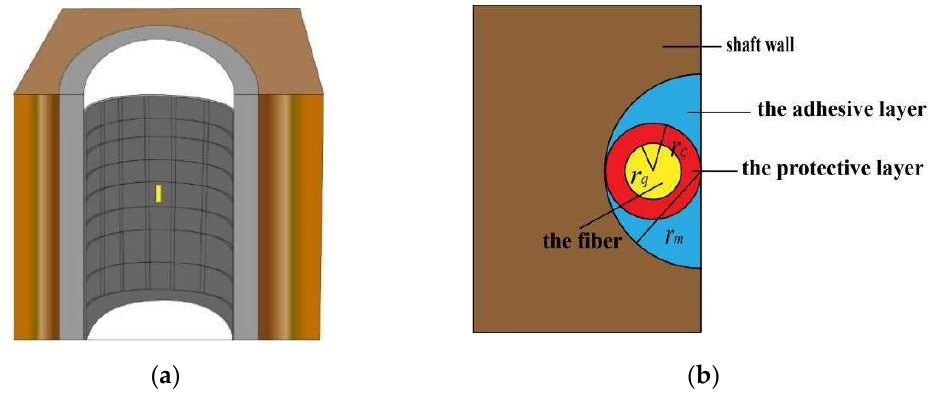
Figure 3. The FBG sensor arrangement model diagram: ( a ) cross-sectional view; ( b ) plane-form.